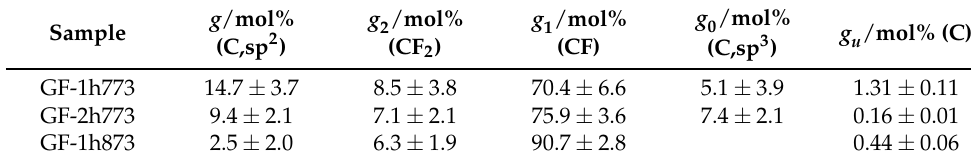
Table 2. Quantitative analysis of 13 C MAS NMR